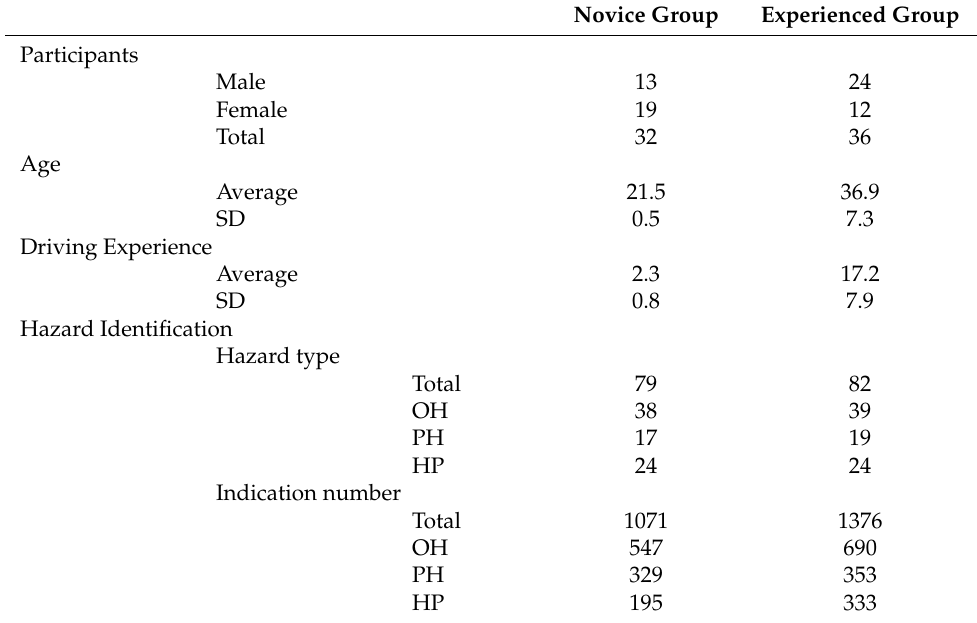
Table 3. Demographic data of